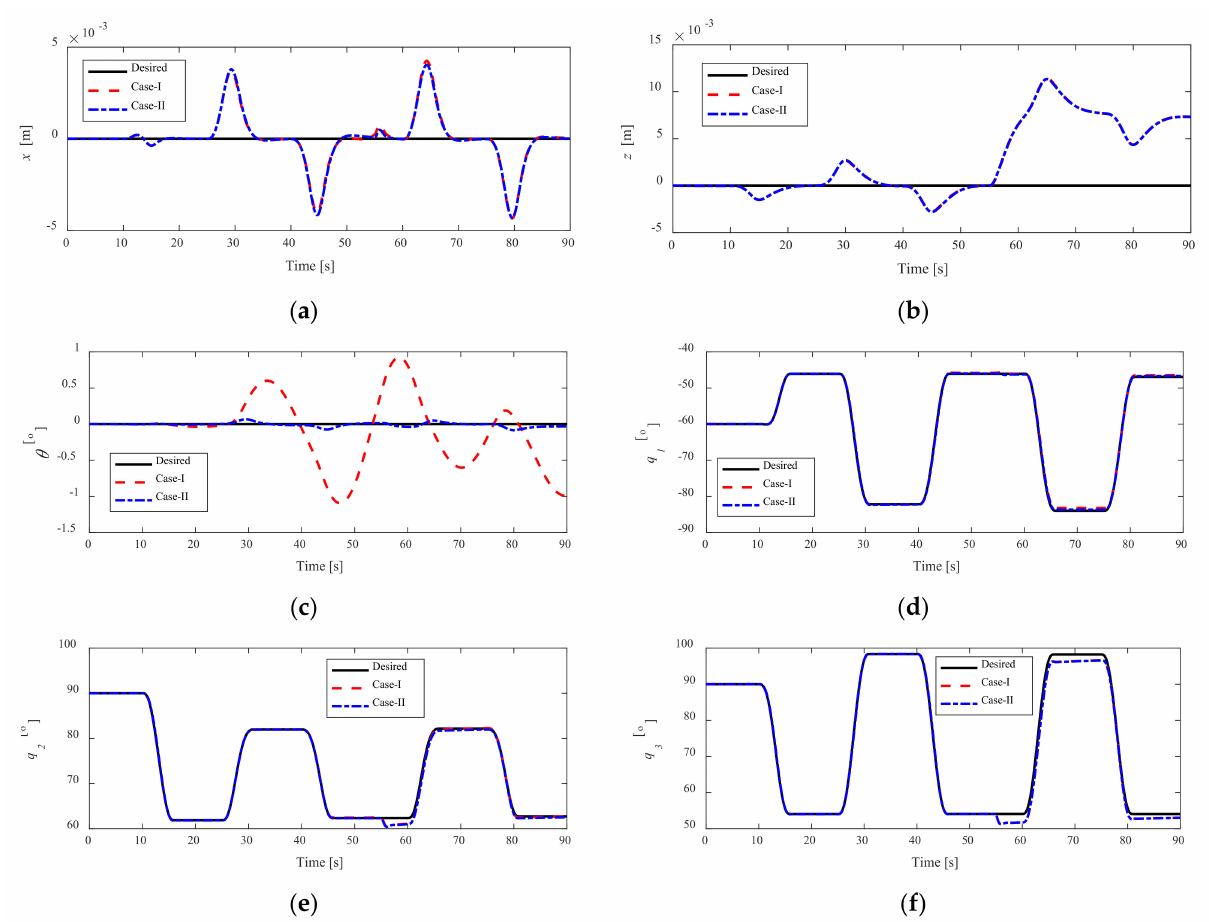
Figure 15. Vehicle and manipulator responses: ( a ) vehicle position response in x-direction; ( b ) vehicle position response in z-direction; ( c ) vehicle attitude response; ( d ) joint q 1 trajectory responses; ( e ) joint q 2 trajectory responses; ( f ) joint q 3 trajectory